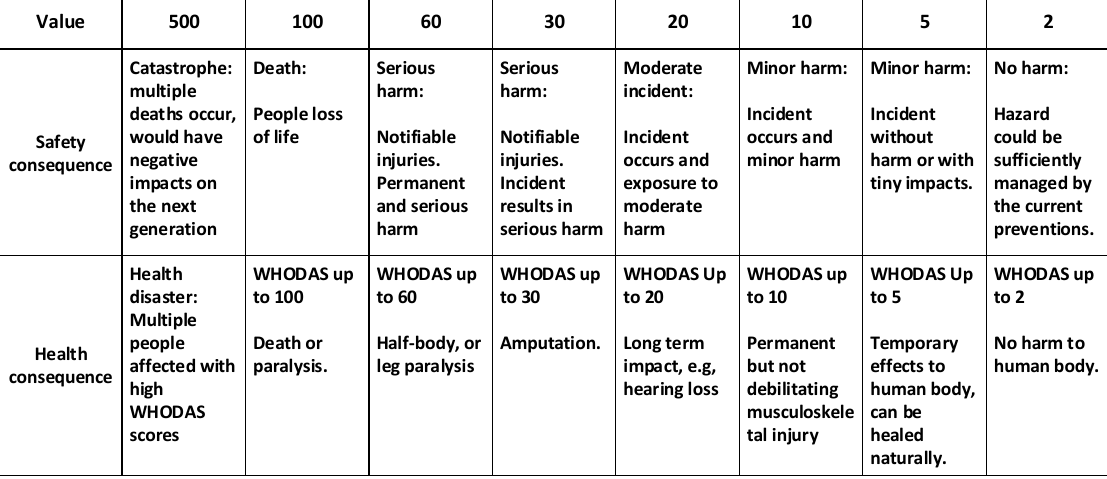
Figure 6. Severity of consequence description.